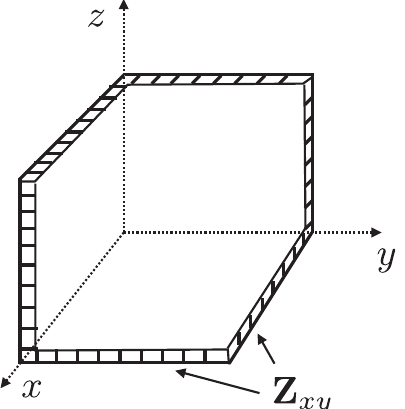
FIG. 13. The operator Z acts on the gauge field by changing xy by Z ∈ G the values of the gauge field variables on the indicated links; in other words, it inserts a Z flux in the z direction. Similarly, operators that insert flux in the other directions act in the other